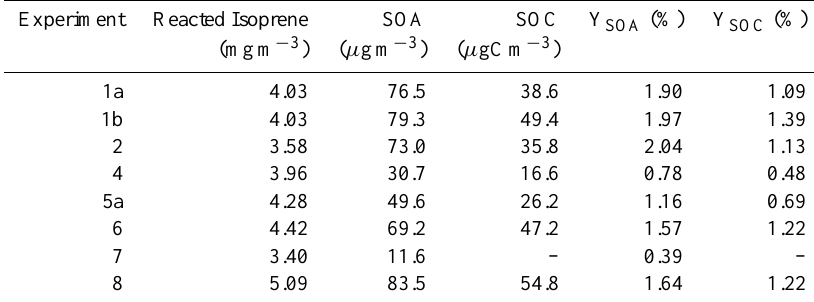
Experiment Reacted Isoprene SOA SOC Y SOA (%) Y SOC